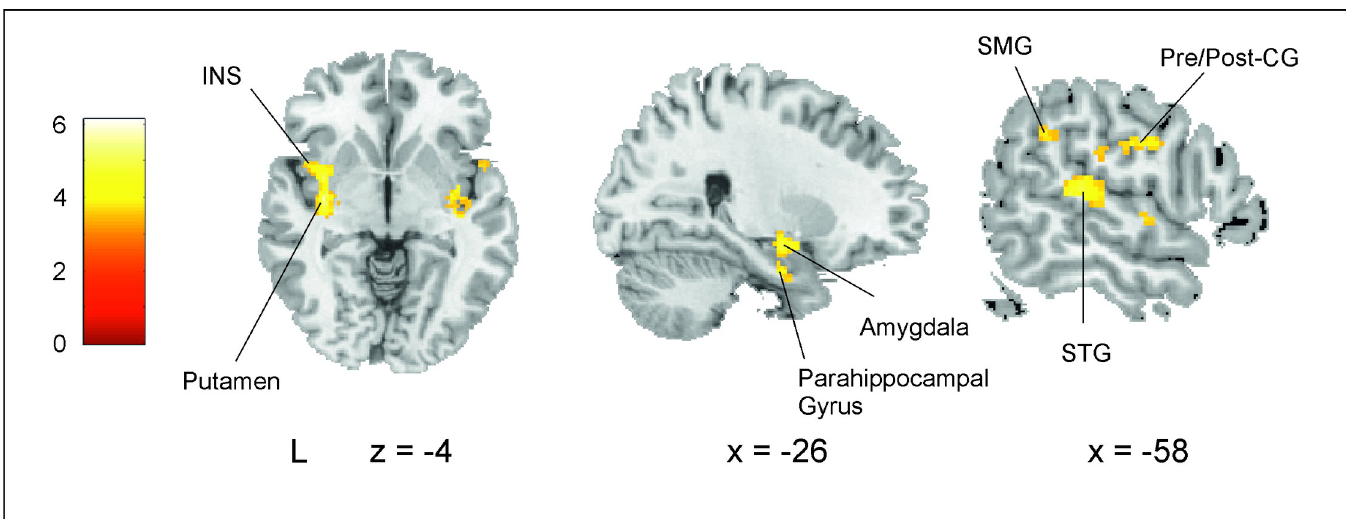
Fig 5. Brain regions related to mean SL (i.e., NADs block vs. Random block activity covarying with the NADs effect). Significant brain activity for the NADs block minus the Random block covarying with the NADs effect, i.e., an aggregate measure of SL. Results are reported for clusters FWE-corrected at p < 0.001 at the cluster level (minimum cluster size = 20). MNI coordinates were used. Data used to generate Fig 5 can be found in http://identifiers.org/neurovault.collection:10421. BA, Brodmann area; CG, central gyrus; FWE, family-wise error; INS, insula; NAD, nonadjacent dependency; SL, statistical learning; SMG, supramarginal gyrus; STG, superior temporal